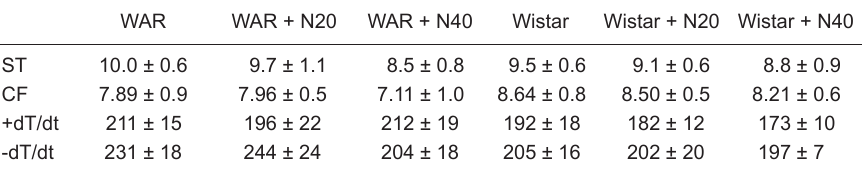
204 ± 18 205 ± 16 202 ± 20 197 ± 7 Data are reported as means ± SEM for 6 rats per group. No significant differences were observed among any of the groups. N20 and N40 = 20 and 40 mg/kg nifedipine, respectively; ST = systolic tension (g); CF = coronary flow (mL/min); WAR = Wistar audiogenic